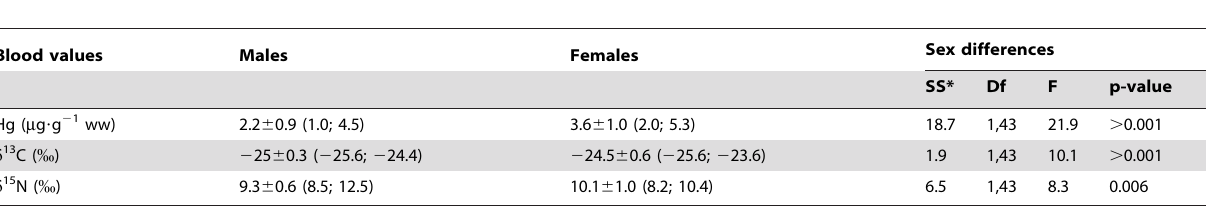
Table 1. Blood Hg concentrations, d 13 C and d 15 N values in pre-laying snow petrels in relation to sex.